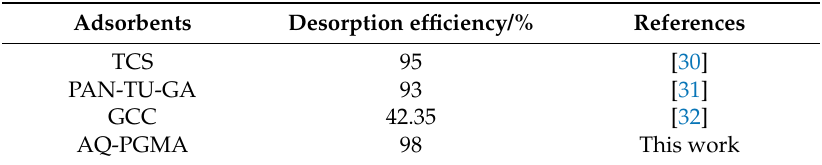
Figure 7. Effect of reused cycles on the recovery of Pd(II) after successive cycles of adsorption/desorption. Table 6. Regeneration efficiency of AQ-PGMA against other sorbents reported in the